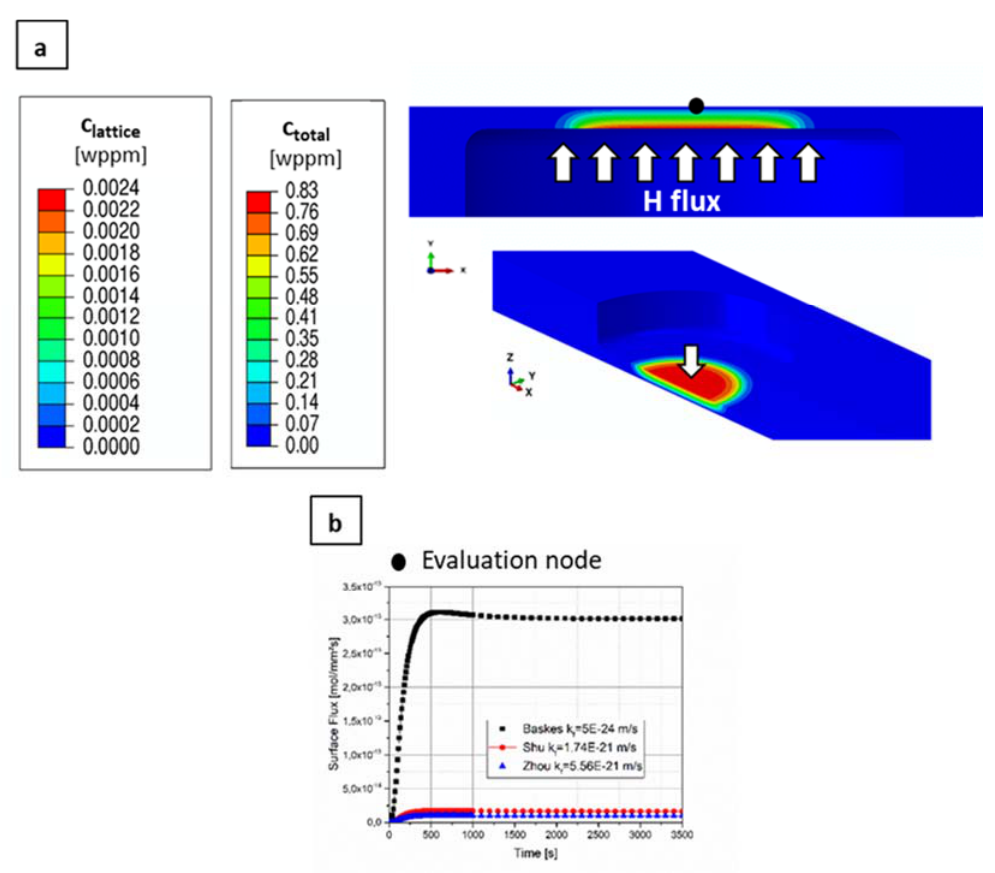
Figure 14. ( a ) H concentration distribution through the thickness of the CP steel sample, the arrows indicate the direction of H charging from the bottom of the samples; and, ( b ) H flux over time in an evaluation node on the top surface of the sample.